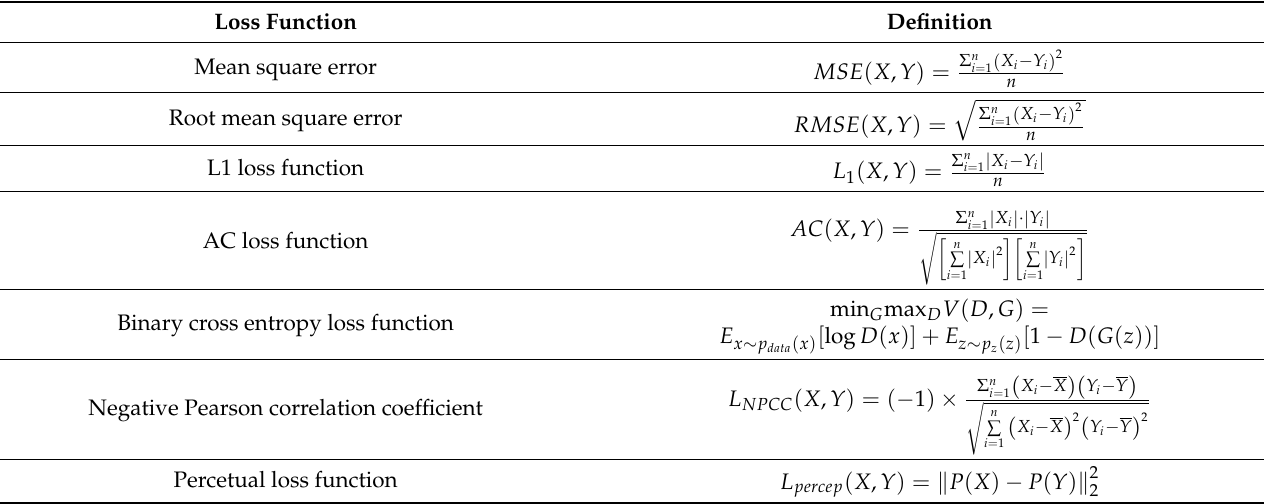
Table 2. The definition of loss functions.